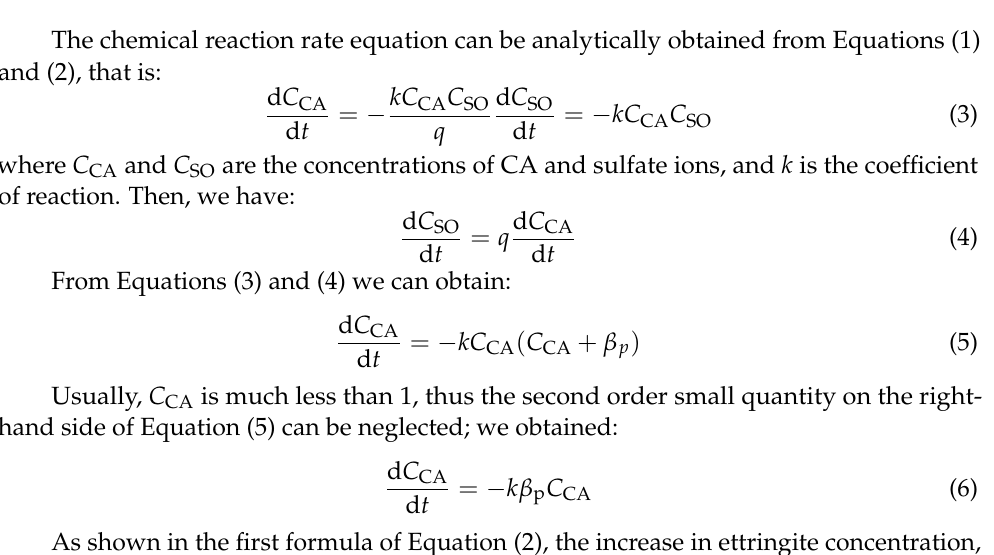
Figure 1. ( a ) SEM image of damage in a concrete sample immersed in sodium sulfate solution with 8% concentration for 250 days, and ( b ) the energy spectrum of ettingite. Chen et al. [37] proposed an empirical formula to describe the corrosion damage evolution. The damage degree D is defined as the volume occupied by microcracks per unit volume. Therefore, D can be considered as the sum of all crack volumes in a unit volume of concrete, that is: